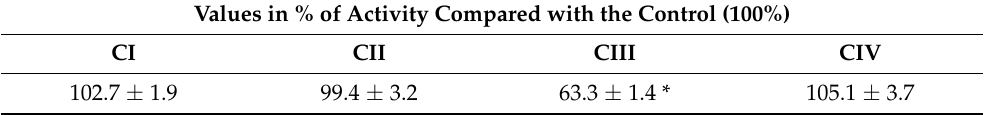
Table 2. Effect of S-15176 difumarate salt (30 µ M) on the activity of complexes (CI-IV) of the mito- chondrial respiratory chain. Values in % of Activity Compared with the Control (100%) CI